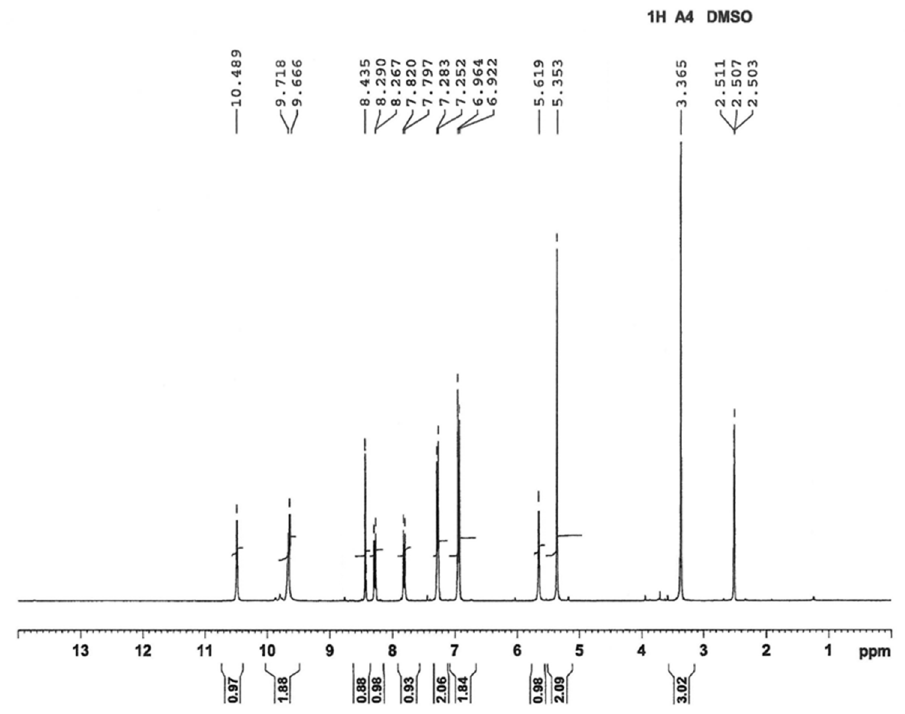
Figure 2. 1 H-NMR spectra of 1-(5 ′ -nitrobenzimidazole-2 ′ -yl-sulphonyl-acetyl)-4-(p-methoxy- phenyl)-thiosemicarbazide ( VII ).